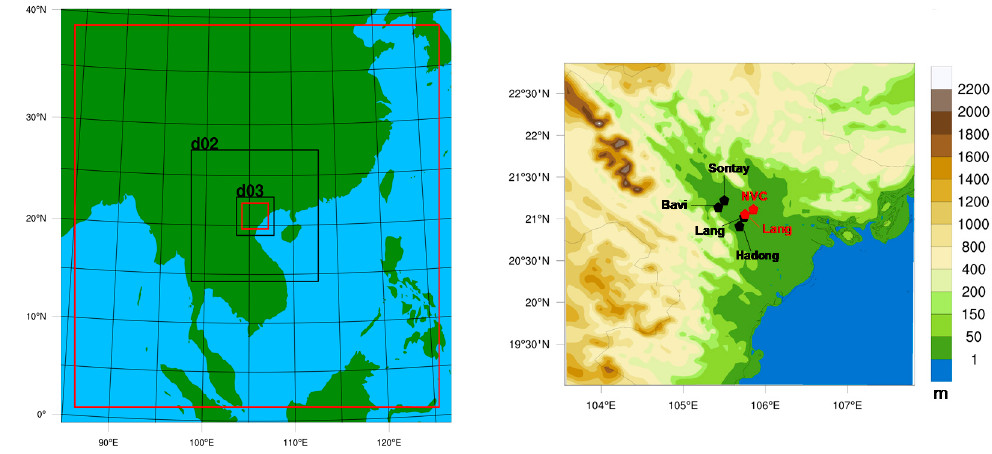
Figure 2. ( Left ) Three nested domains for WRF (black boxes) and CMAQ (red boxes). d02 for CMAQ is not shown because we did not consider it in this study. ( Right ) Terrain height with location of each station in d03.